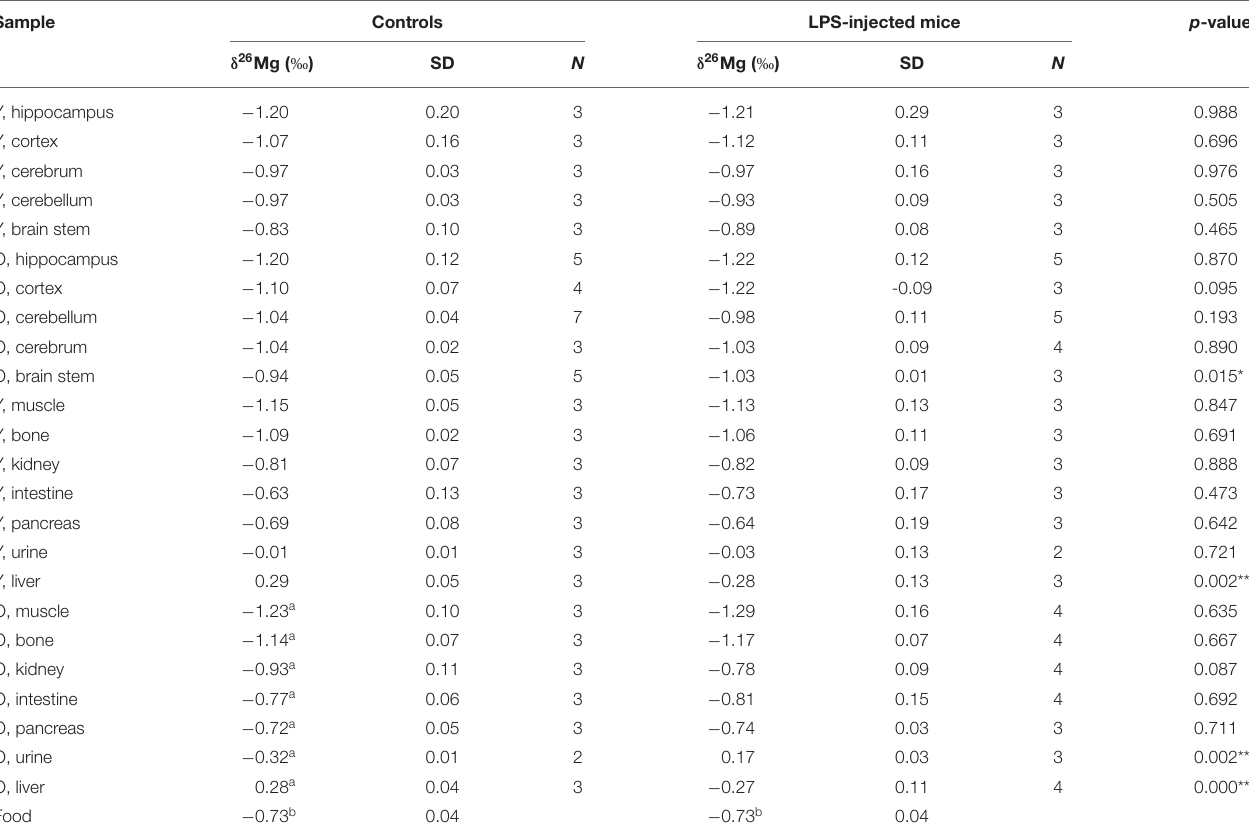
TABLE 3 | Mg isotope distribution in controls and LPS-injected mice.